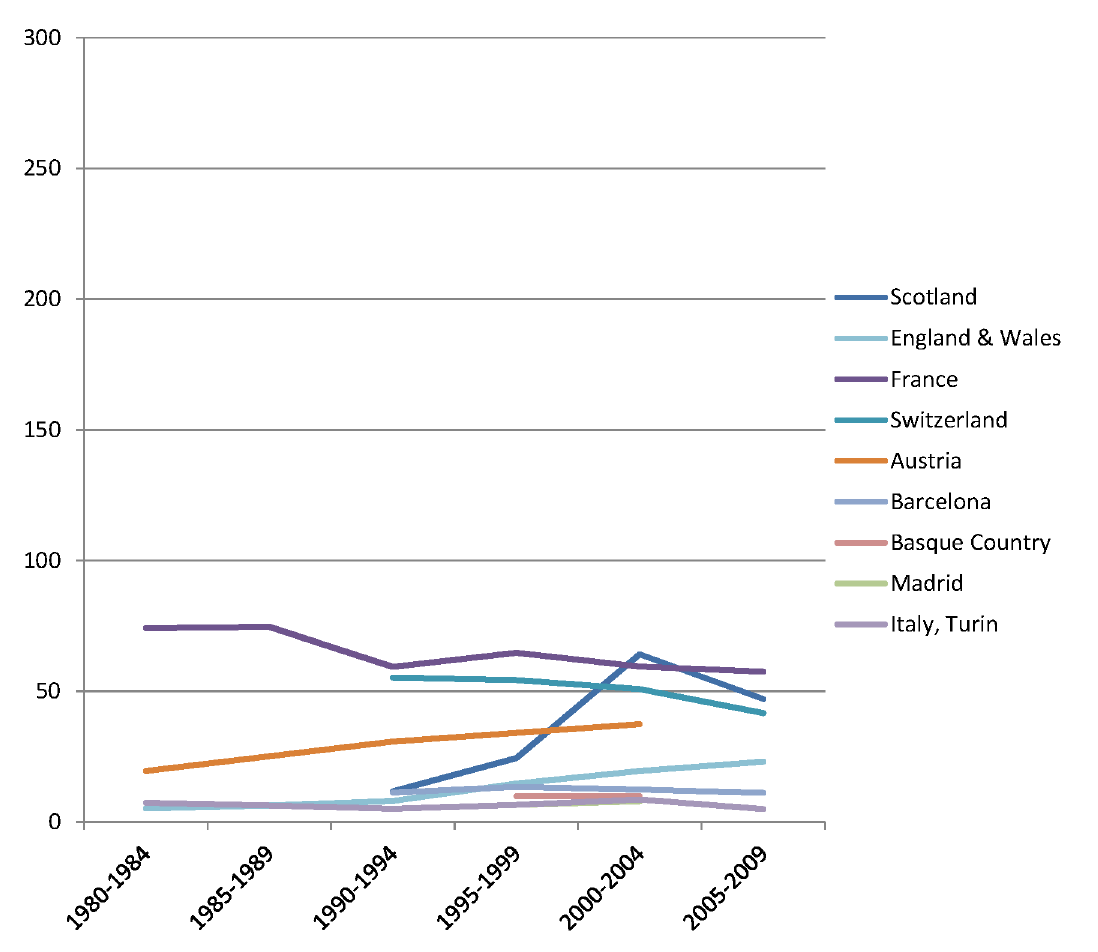
Fig 6. Trends in age-adjusted mortality from alcohol-related causes among men aged 35 – 79 y in the low education group in Western and Southern European countries/regions, ca. 1980 – 2010, by country/region. The y- axis shows age-adjusted alcohol-related mortality in deaths per 100,000 person- years. In England and Wales, individuals in the low and middle education groups could not be distinguished before 2000, and therefore both groups have been combined in the low education group in all study